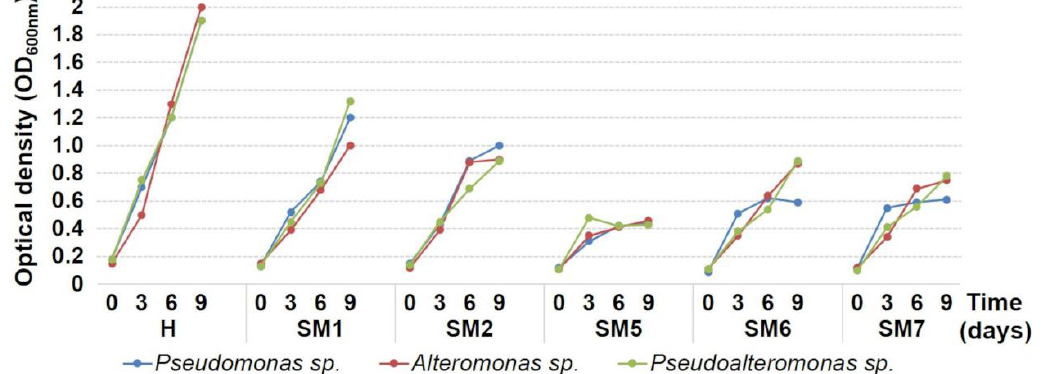
Figure 7. Growth curves (measured by optical density) of bacterial strains versus time during culti- vation in the presence of five selected Cu- and Ag-based biocidal materials and a blank test carried out with the H resin, biocide-free.